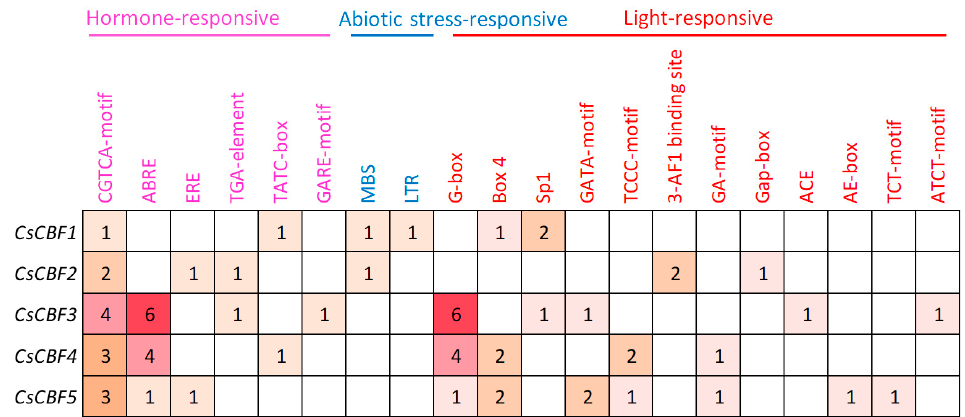
Figure 2. Prediction of cis-elements in the CsCBF gene promoters. The numbers of different cis-elements in the CsCBFs are indicated by numbers and different colors in the grid.